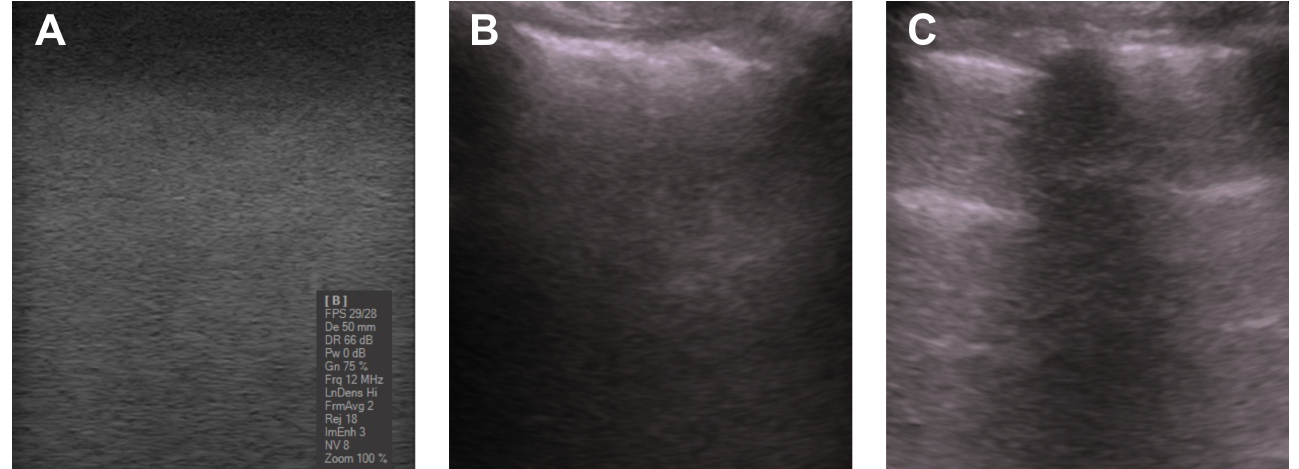
Figure 3. ( A ) US image of the fabricated PVA-C phantoms mimicking the healthy parenchyma. ( B ) Lung US of a subject with pleural thickening on the underlying healthy parenchyma as well as the shadow caused by the ribs. ( C ) Lung ultrasound of a healthy subject showing the A-lines typically observed in the normal parenchyma. The details of the acquisition for the images ( B , C ) can be found in [50,51].